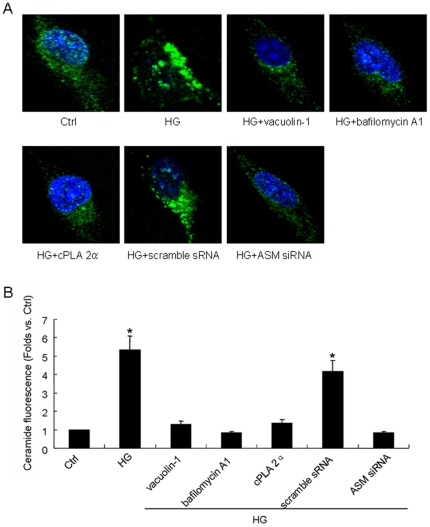
Effect of HG on ceramide fluorescence and the performance after lysosomal inhibition or ASM gene silencing.A: representative images of ceramide fluorescence in the cells which were cultured in normal glucose (5.6 mmol/l, Ctrl) or high glucose (22 mmol/l, HG) medium for 12 h with or without the pretreatment by vacuolin-1(10 µmol/l), bafilomycin A1 (100 nmol/l) or cPLA 2α (20 µmol/l) for 1 h or by the transfection of scramble small RNA (sRNA) or ASM small interfering RNA (siRNA). B: summarized results of ceramide fluorescent abundance in different groups. Values are means±SE; n = 5 batches of cells. * P<0.05 vs. Ctrl.